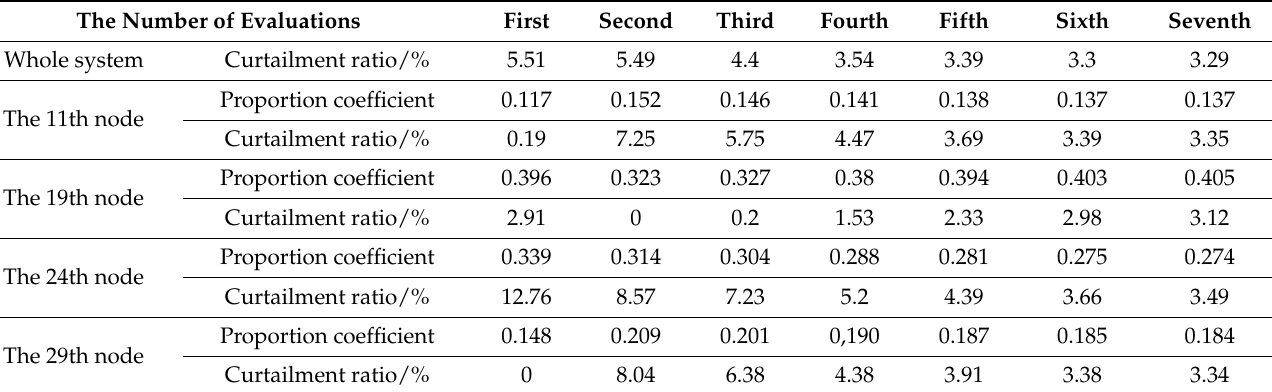
Figure 6. Dispatching scheme of PV and ES system at each node; ( a ) actual output curve of PV; ( b ) dispatching scheme of ES. Table 1. Curtailment ratio of PV power under different ratios.